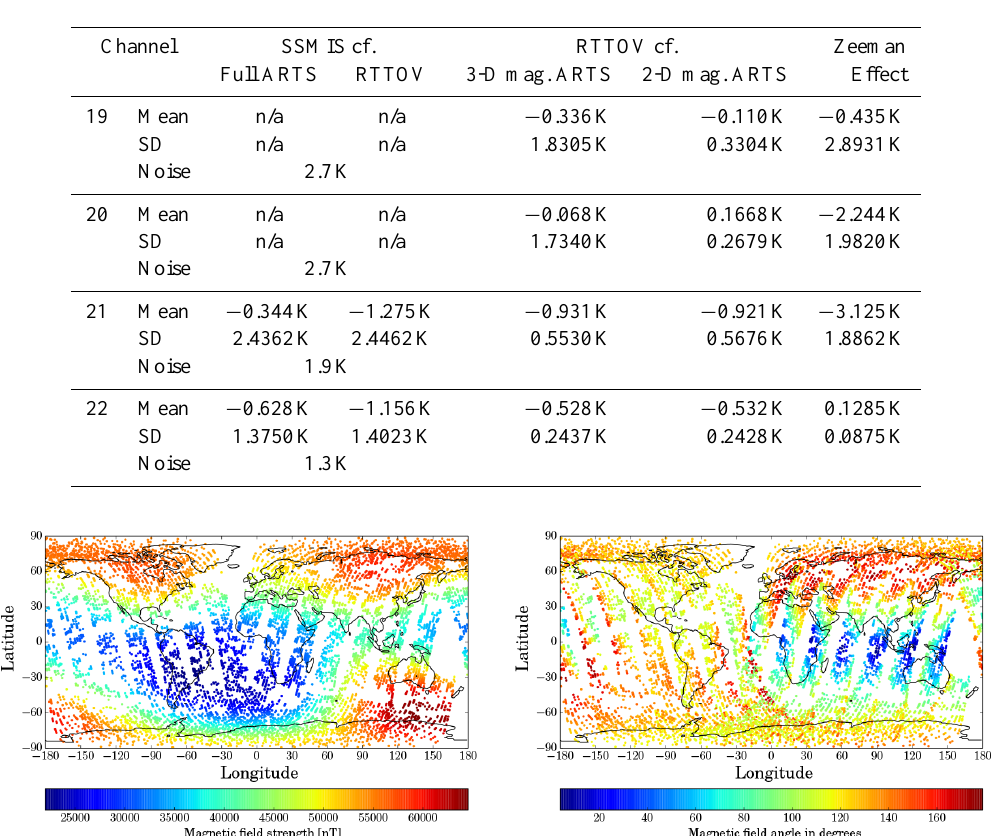
Table 1. Mean and standard deviations of our comparison for the four SSMIS channels. The left two columns with data are a direct compar- ison between the SSMIS data set and the corresponding full model simulations. The rightmost column shows the Zeeman effect by turning the effect on and off in ARTS. The remaining columns compare RTTOV simulations with ARTS simulations using three-dimensional and two-dimensional magnetic fields. SD denotes standard deviation. n/a denotes data that are not applicable. Noise levels are from Kunkee et al. (2008).